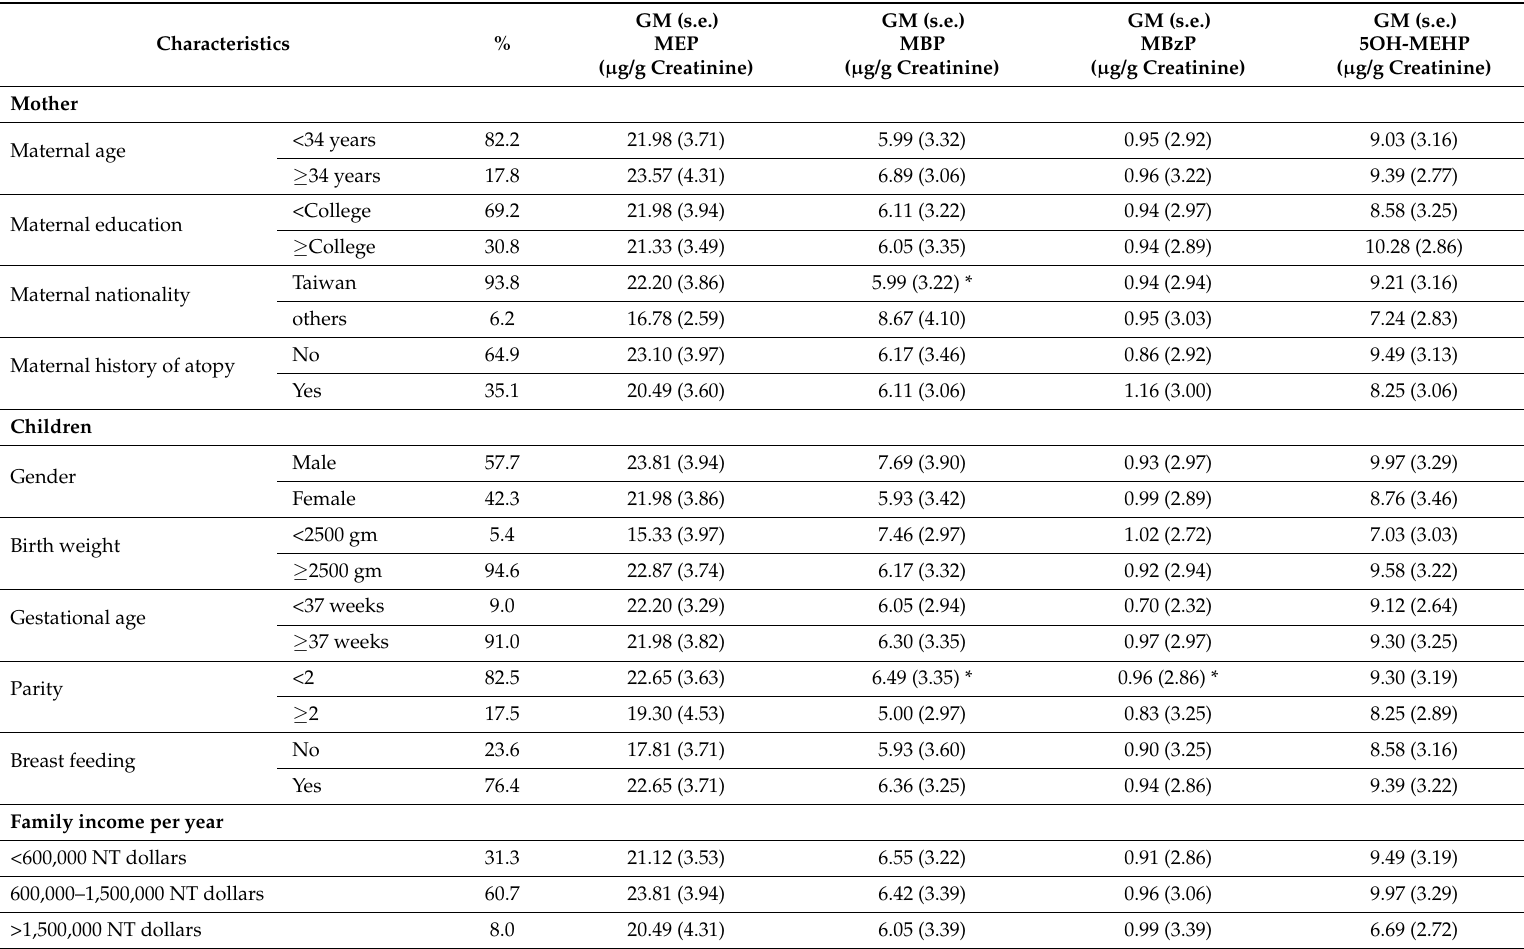
Table 1. Basic demographics of the study population in terms of geometric means (s.e.) of urine phthalate metabolites concentrations ( n = 453).